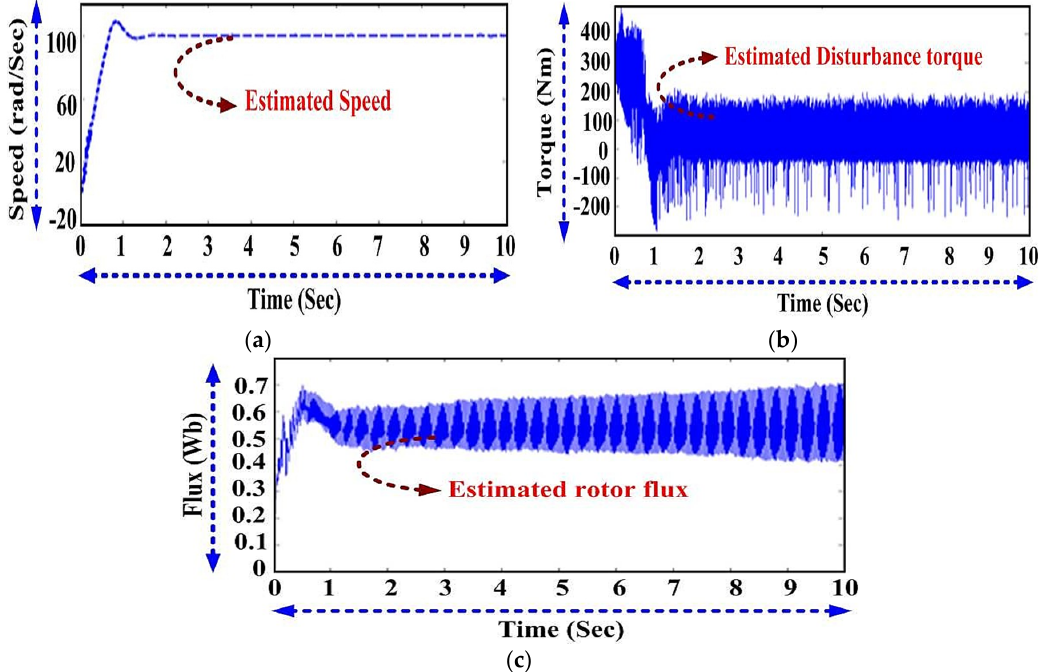
Figure 6. SMLO2: ( a ) estimated speed; ( b ) estimated torque and ( c ) estimated rotor flux.